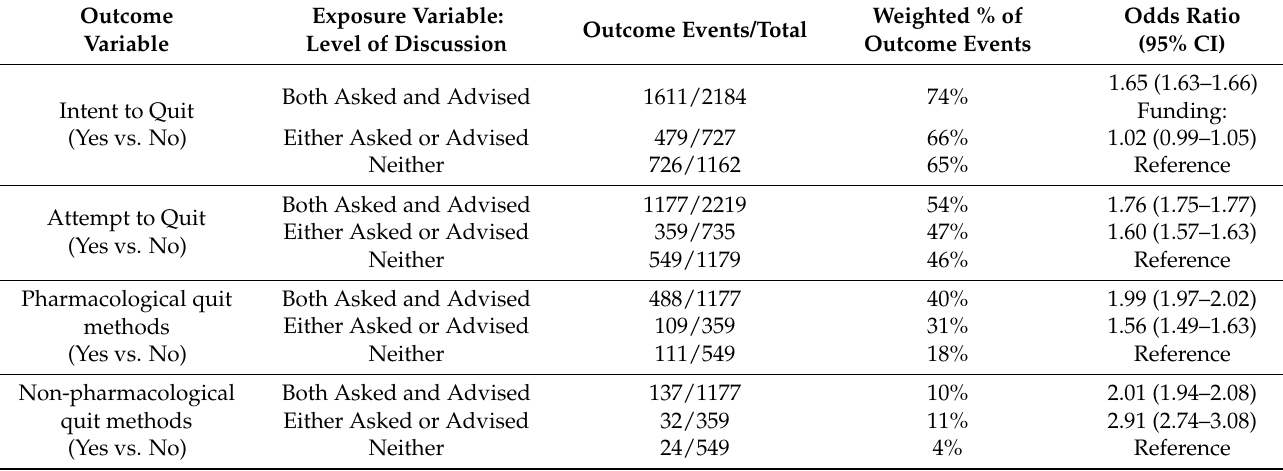
Table 2. The association between provider–patient discussion and quit behavior outcomes: quit intent, quit attempt, and quit methods from an instrumental variable analysis.